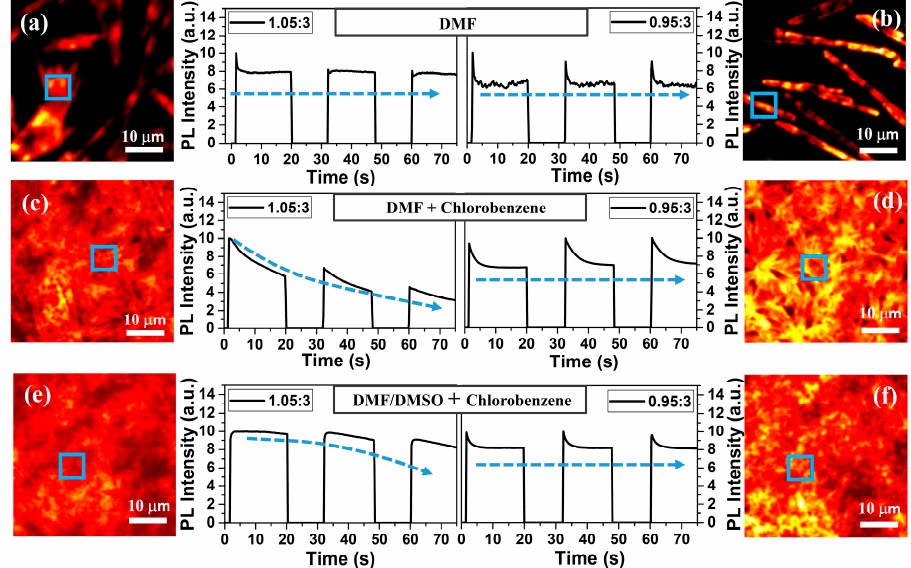
Figure 3. PL morphology and traces of different samples. During the interval in each PL trace, the sample was kept in the dark. ( a , b ) were prepared by spinning the precursors dissolved in DMF, ( c , d ) were prepared by spinning with chlorobenzene dropping, and the precursors were also dissolved in DMF, ( e , f ) were prepared by spinning with chlorobenzene dropping, and the precursors were dissolved in DMF/DMSO. ( a , c , e ) were prepared from PbI 2 ‐ rich (5%) solutions, and ( b , d , f ) were prepared from PbI 2 ‐ deficient (5%) solutions. The blue squares in the PL images indicated the measured regions. The excitation power density was 5 W/cm 2 , the excitation wavelength was 532 nm.